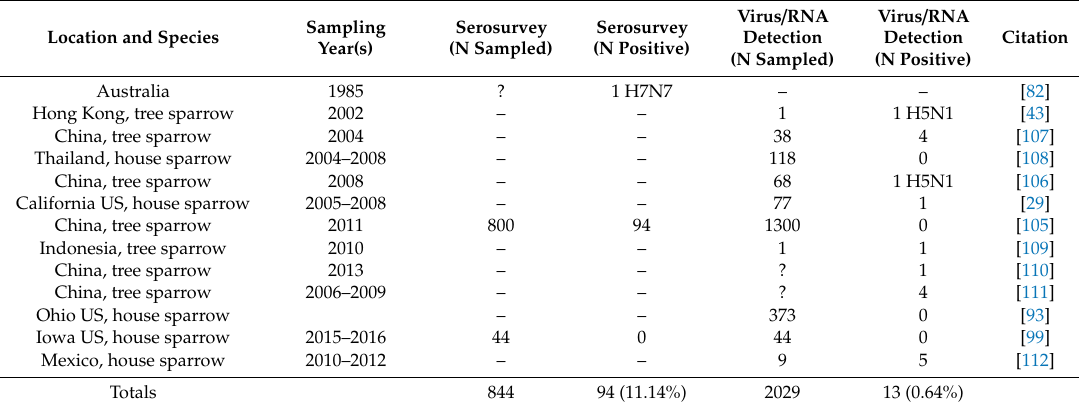
Table 3. Avian influenza A virus surveillance of house sparrows and tree